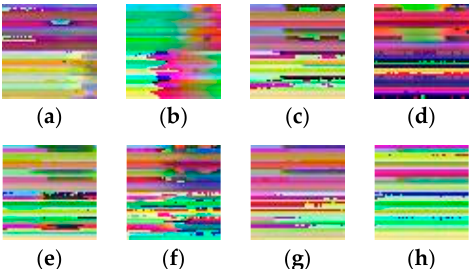
Figure 3. Sample feature images generated on NTU RGB + D dataset. ( a ) Kicking other person; ( b ) pushing other person; ( c ) patting on back of other person; ( d ) pointing finger at the other person; ( e ) hugging other person; ( f ) giving something to other person; ( g ) touching other person’s pocket; ( h )